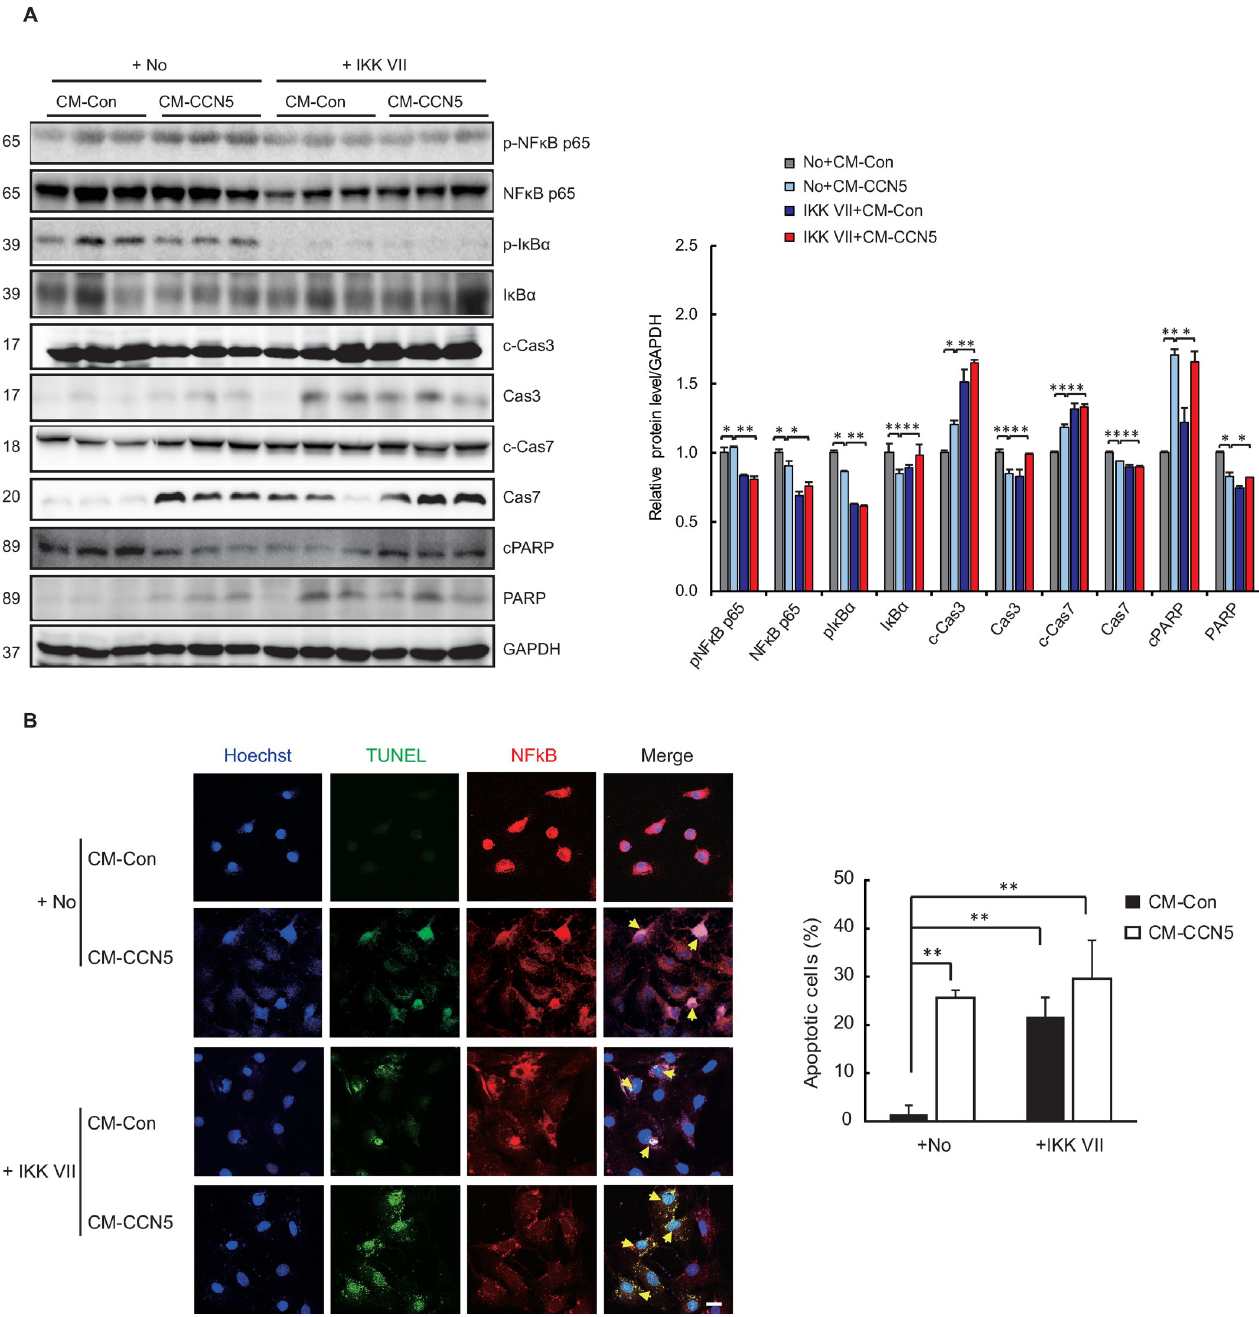
Fig 3. NF κ B protects MyoFBs from apoptosis. Freshly prepared FBs were trans-differentiated to MyoFBs by treating them with 10 ng/mL TGF- β for 48 hours. MyoFBs were then cultured in control conditioned media (CM-Con) or CCN5-containing conditioned media (CM-CCN5) for a further 48 hours in the presence or absence of 1 μ M IKK VII, a selective I κ B kinase inhibitor. (A) Cell lysates were used for western blotting analysis of NF κ B p65, phosphorylated NF κ B p65 (p-NF κ B p65), I κ B, phosphorylated I κ B (p-I κ B), caspase 3 (Cas3), cleaved caspase 3 (c-Cas3), caspase 7 (Cas7), cleaved caspase 7 (c-Cas7), Poly (ADP-ribose) polymerase (PARP), and cleaved PARP (cPARP). GAPDH was used as a loading control. (B) Cells were co-stained with TUNEL (green) and p53 (red). Hoechst dye was used for nuclear staining. TUNEL-positive apoptotic cells were counted and plotted. Scale bar is 50 μ m. For each group, three independent cultures were prepared and treated (n = 3). � P < 0.05, �� P < 0.01.